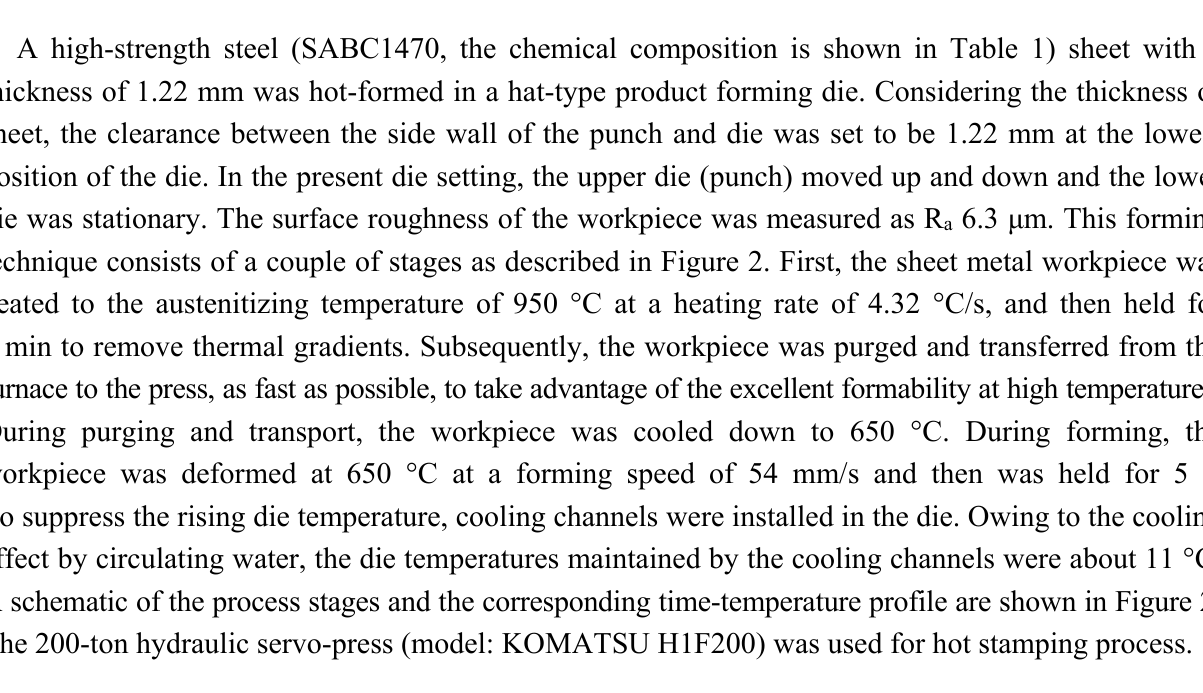
Figure 1. A hat-type product design for the present hot stamping test.